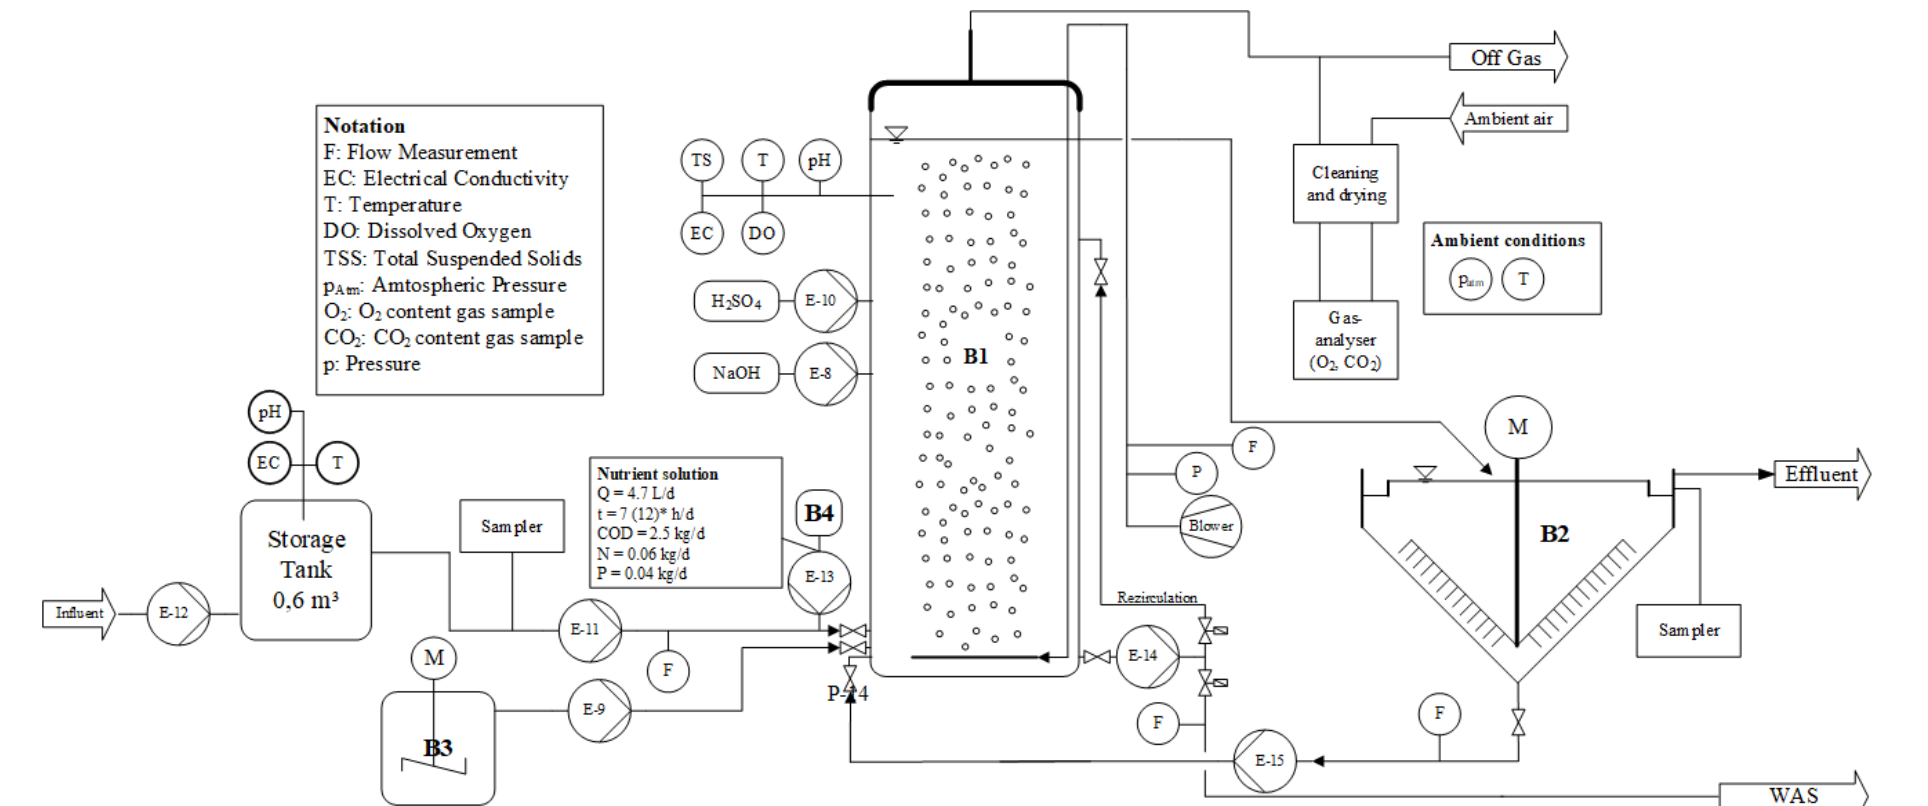
Figure 1. Scheme of the pilot-scale activated sludge plant with off gas testing equipment.